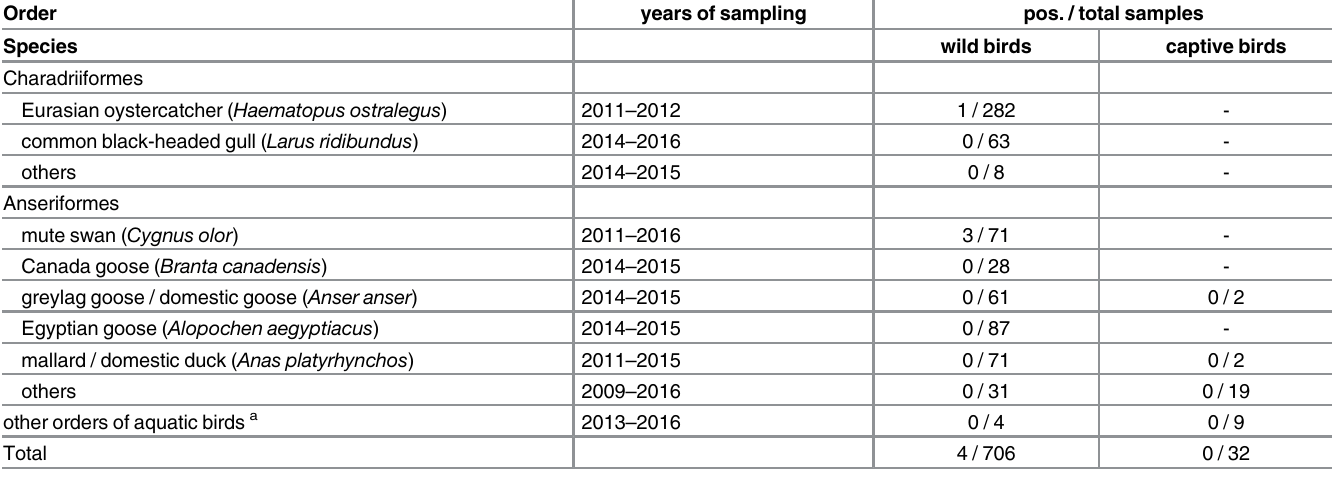
Table 2. Detection of ABBV-1 by RT-PCR from aquatic birds in Germany, 2009 – 2016. Order years of